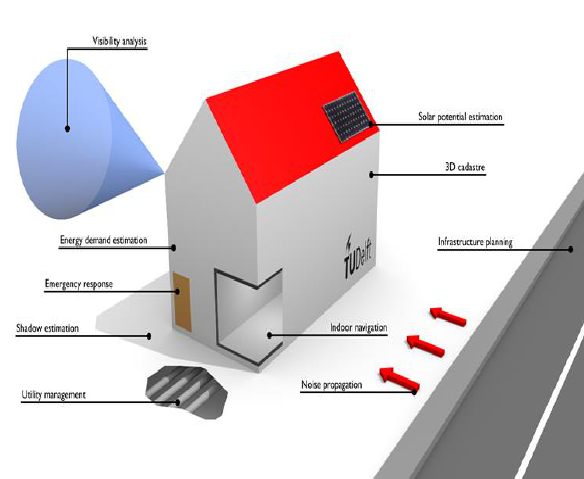
Figure 2 – Various application domain of 3D CityGML models (Biljecki F et al,